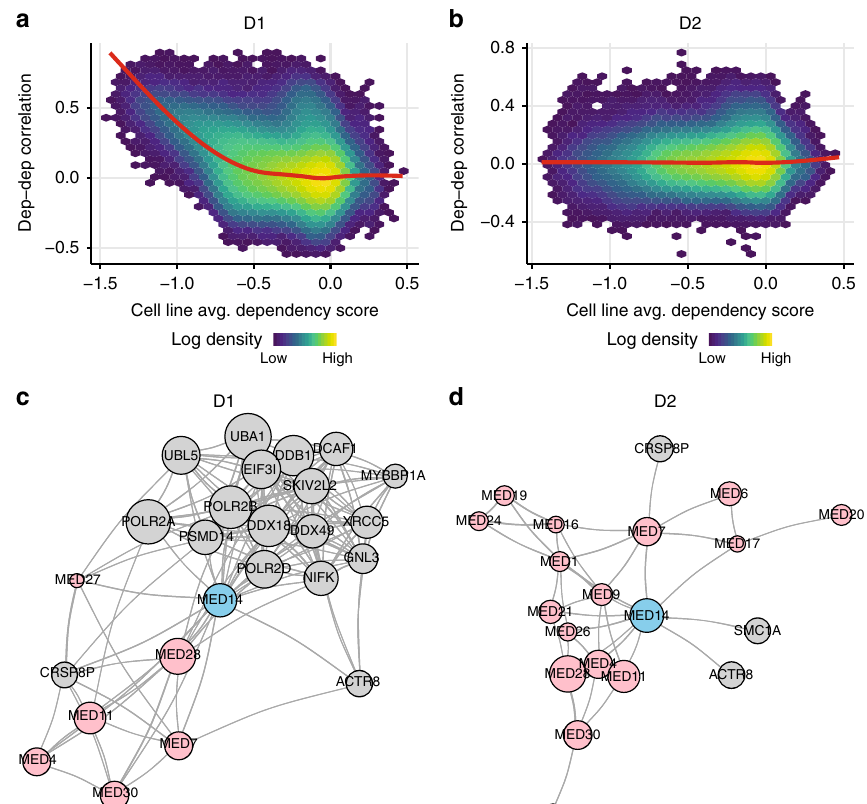
Fig. 3 Screen quality biases impair dependency correlation analyses. a Correlation between pairs of gene dependency pro fi les, estimated using D1 applied to the Achilles data, increased systematically for gene pairs that were more essential on average. Red line shows the smoothed average. Color shows the density of data points in each region (log color scale). b Same as a but using D2, showing that the systematic upward bias in the pairwise correlation between pairs of common essential genes is removed. c Gene dependency correlation network surrounding MED14 , constructed using D1 dependency estimates applied to the DRIVE dataset. Each node represents a gene, with edges depicting strong pairwise correlations (see Methods). Red nodes indicate genes that form protein complexes with MED14 . Node size indicates the across-cell-line average dependency score for each gene (larger nodes representing more common-essential genes). d Same as c using D2, showing that the local dependency correlation network for MED14 is more enriched